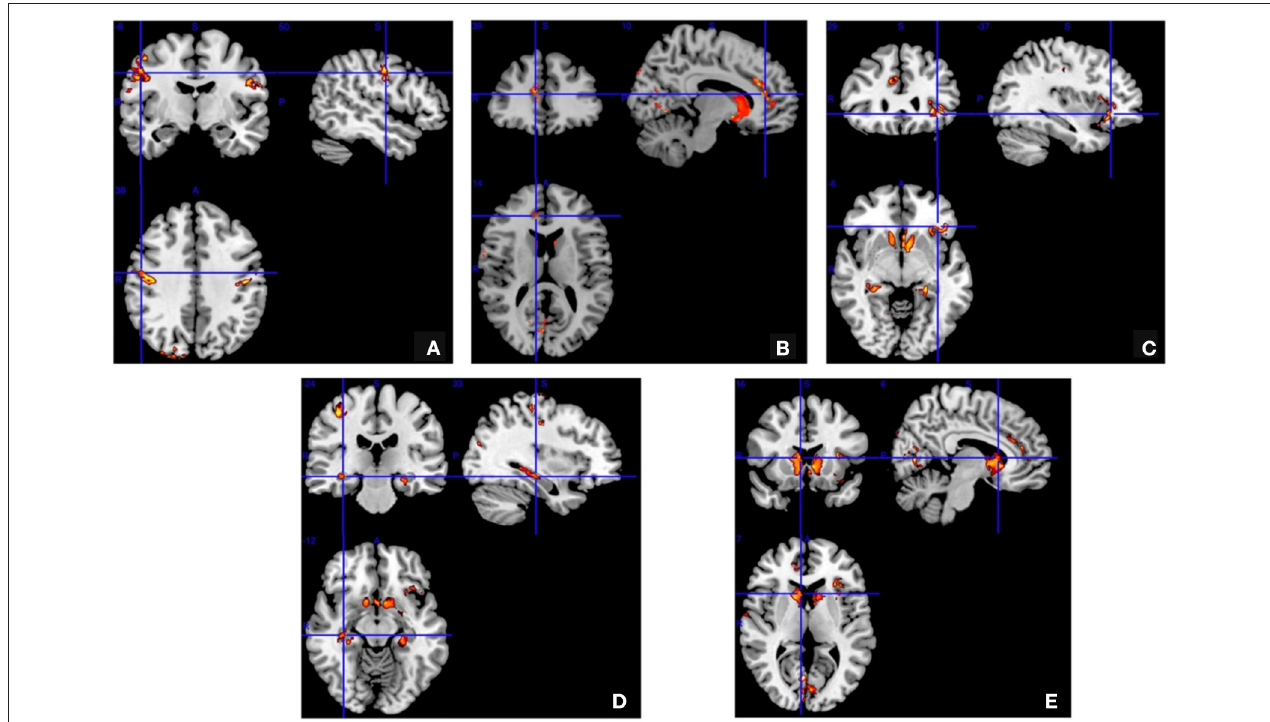
FIGURE 1 | Voxel-based morphometry. The gray matter concentration was decreased in the bilateral pre- and post-central gyrus (A) right anterior cingulate gyrus (B) left posterior orbital region (C) bilateral hippocampus (D) and bilateral caudate nucleus and bilateral occipital regions (E) in the juvenile myoclonic epilepsy patients compared to the normal controls (false discovery rate corrected P < 0.05).